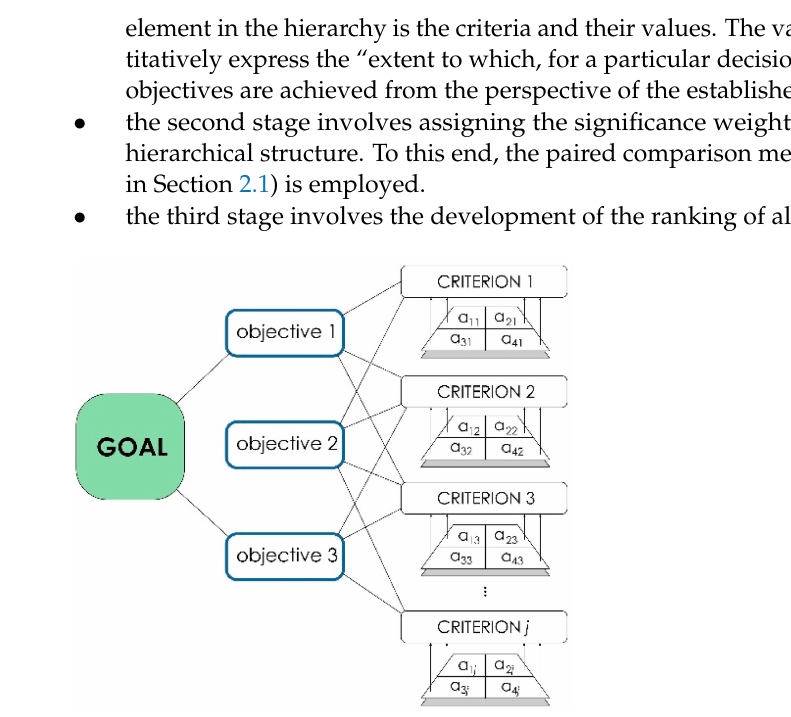
Figure 3. A theoretical hierarchical model in the AHP method, where a ij is the value of j -criterion, assigned to the particular alternative. Source: own study based on